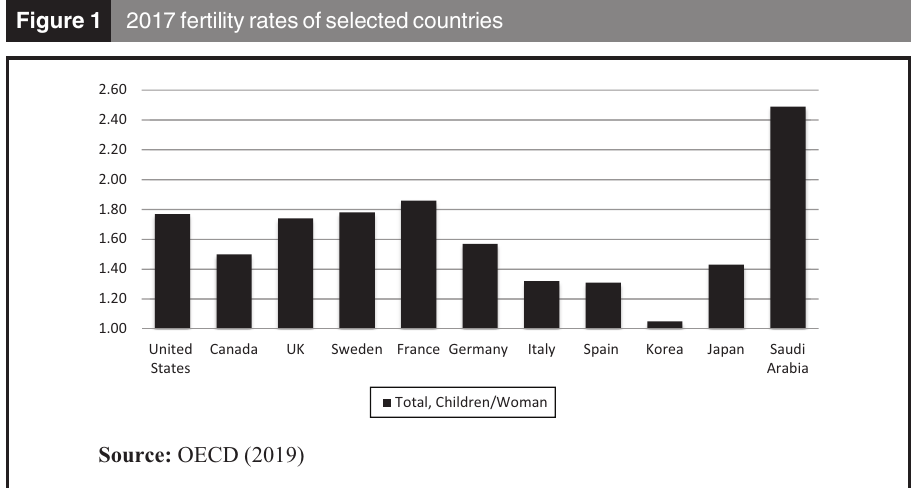
Figure 1 2017 fertility rates of selected countries